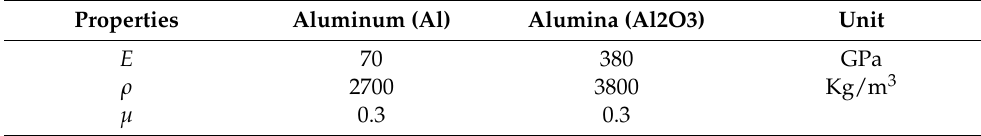
Table 1. Material properties of the FGMs plate.